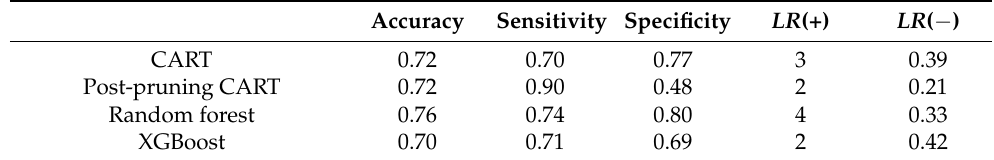
Table 4. Accuracy of all